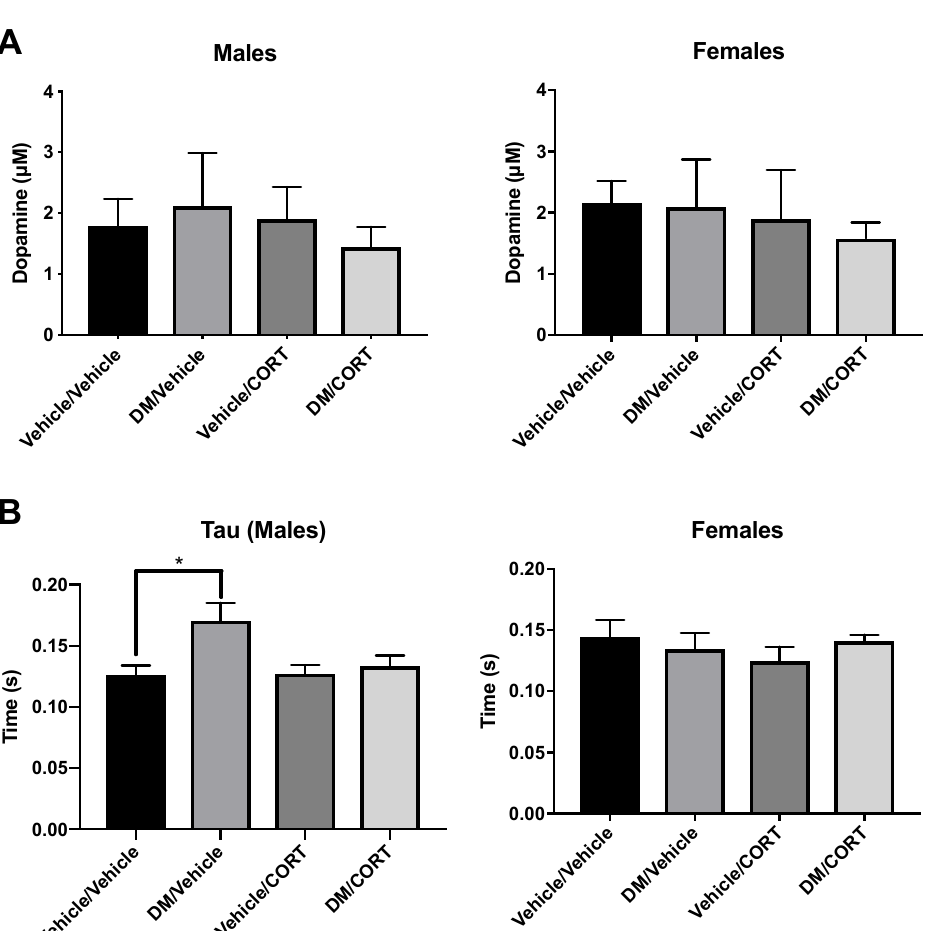
Figure 6. Significant impairment of dopamine uptake occurred in male o ff spring to deltamethrin (DM) only, with no significant change in peak dopamine release. Ex vivo electrochemical measurement of dopamine release and uptake via fast-scan cyclic voltammetry was measured in male and female o ff spring exposed to one of four treatment groups. In ( A ), peak dopamine release was measured in the dorsal striatum and averaged over all stimulation sites per animal. DM, corticosterone (CORT), or DM / CORT exposure did not significantly change peak dopamine release in male or female o ff spring. In ( B ), tau, a kinetic time constant, was used to characterize dopamine uptake into the synapse and tau values were averaged over all stimulation sites per animal. Deltamethrin exposure in males significantly increased tau, which represents a slowed and impaired dopamine uptake into the synapse. Exposure group di ff erences were evaluated via one-way ANOVA with Tukey’s post-hoc analyses, stratified by sex. * p < 0.05, N = 5–7, and error bars represent SEM.